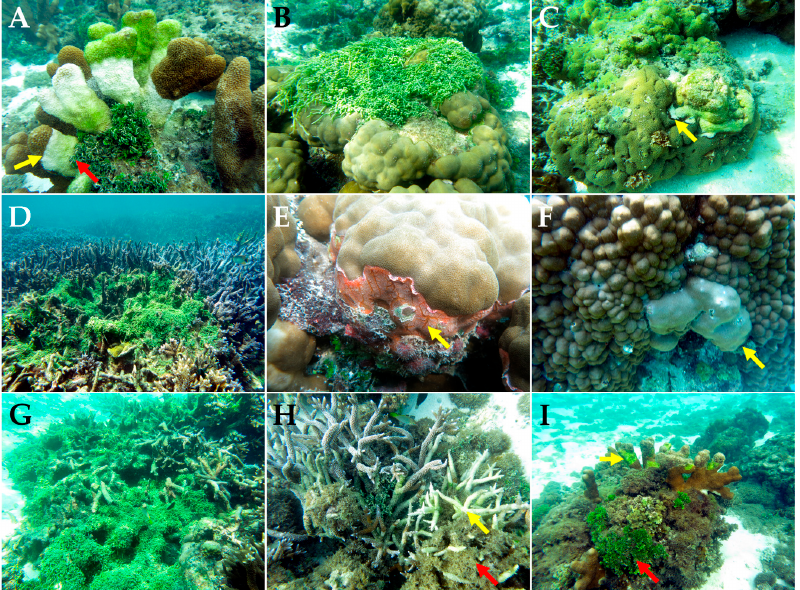
Figure 4. Kalpeni: ( A ) White syndrome in I . palifera (yellow arrow) along with overgrowth and coral contact with H. opuntia (red arrow); ( B ) C. racemosa in Porites spp.; ( C ) BBD in P. varians (yellow arrow depicting progressing cyanobacterial band); ( D ) C. racemosa overgrowing Acropora dominated reefs; ( E ) coral competing sponge overgrowing Porites sp.; ( F ) GAs in Porites sp.; ( G ) coral mortality due to C . racemosa overgrowth ( H ) Multifocal acute tissue loss/White Syndrome in A. muricata (Yellow arrow) followed by algal overgrowth (red arrow); ( I ) Algal overgrowth of white syndrome affected I . palifera (yellow arrow), along with the presence of H . opuntia (Red arrow) [Photographs by R.R. Das, C.R. Sreeraj, and G. Mohan].